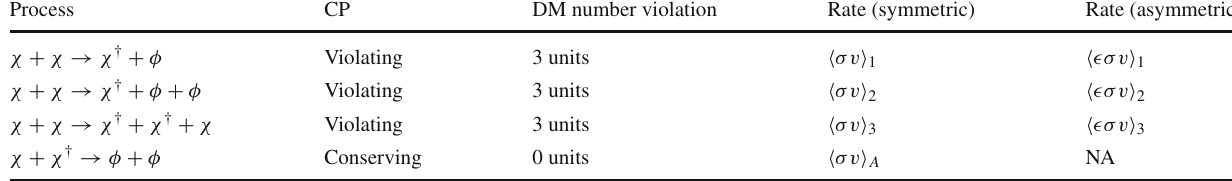
Table 2 Relevant processes for DM cosmology for the ADM from semi-annihilation scenario, their properties, and notation used to denote the corresponding thermally averaged symmetric and asymmetric reaction rates